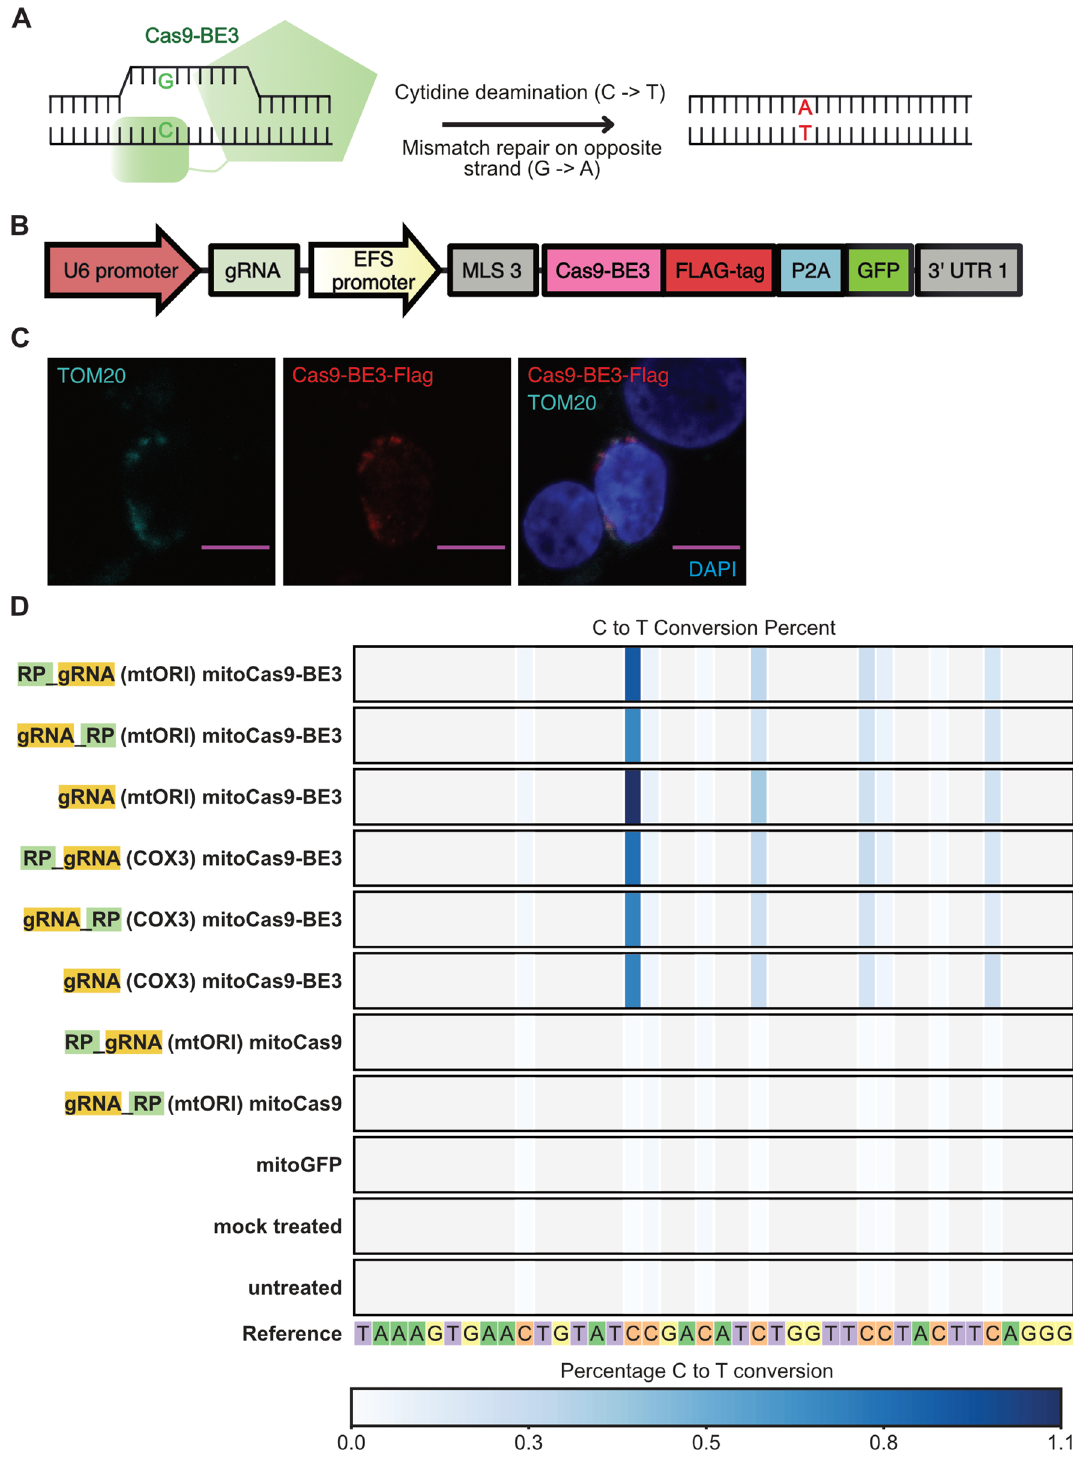
Figure 3. Delivery of base editor Cas9-BE3 into mitochondria. ( A ) Schematic outline of Cas9-BE3 activity. ( B ) Outline of mitochondria-targeted Cas9-BE3. ( C ) Confocal microscopy showing colocalization of FLAG- tagged Cas9-BE3 with mitochondria in HEK 293T cells. Scale bars: 10 μm. ( D ) Frequency of C to T conversions in HEK 293T cells treated with different constructs. Selected part of site within mtDNA that was targeted by mtORI gRNAs is shown. Only successfully transfected, GFP + cells were sorted and analyzed with amplicon next generation